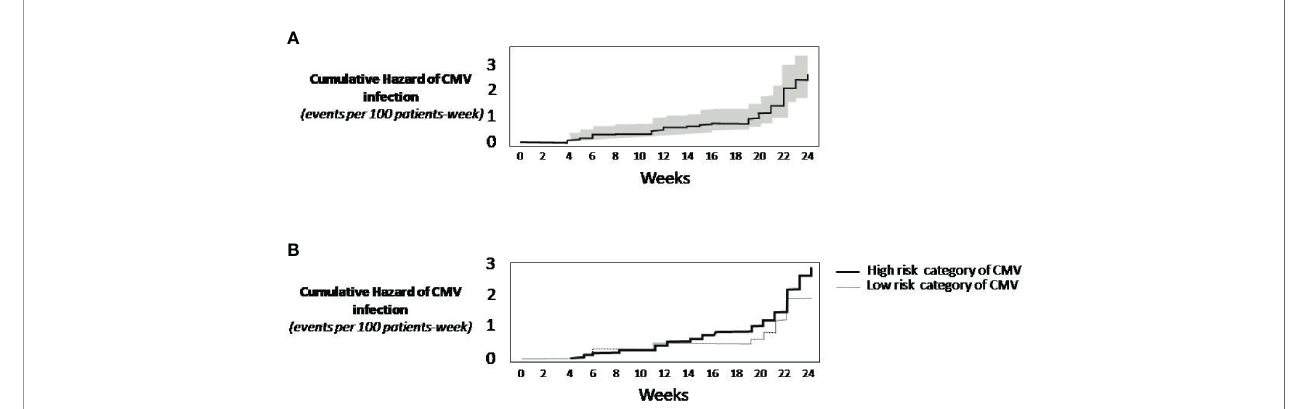
FIGURE 1 | Kaplan-Meier Survival Analysis. (A) Cumulative rate of CMV infection (continuous line). The grey area around the continuous line represents the 95% con fi dence intervals. (B) Cumulative incidence of CMV infection by risk category of CMV. The analysis did not consider the competitive risk of mortality. When not considering the competing mortality risk, the practical implication is that the analysis of CMV infection censors patients who die. As this censoring is assumed to be uninformative, the resulting prognosis should be interpreted as the risk of CMV infection in a hypothetical setting in which patients do not die.